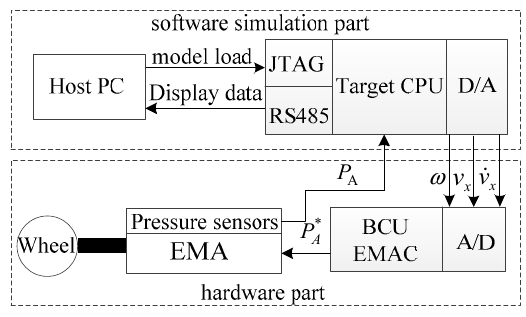
Figure 5. Structure of the HIL experimental platform.